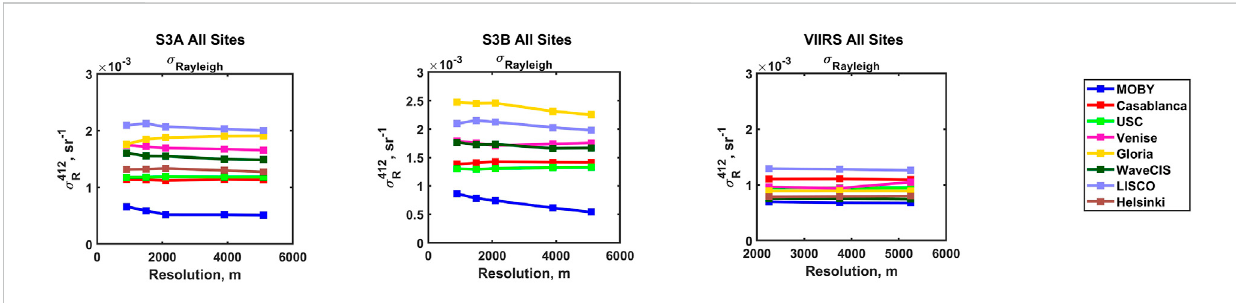
FIGURE 7 Comparison of σ 412 R for OLCI S3A and S3B and